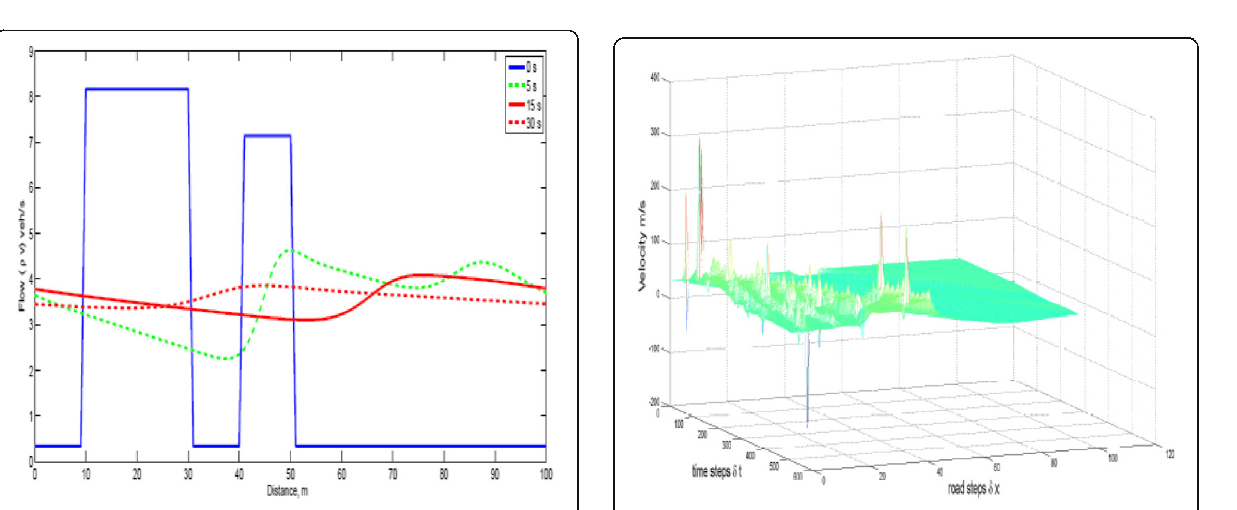
Fig. 10 The PW model velocity